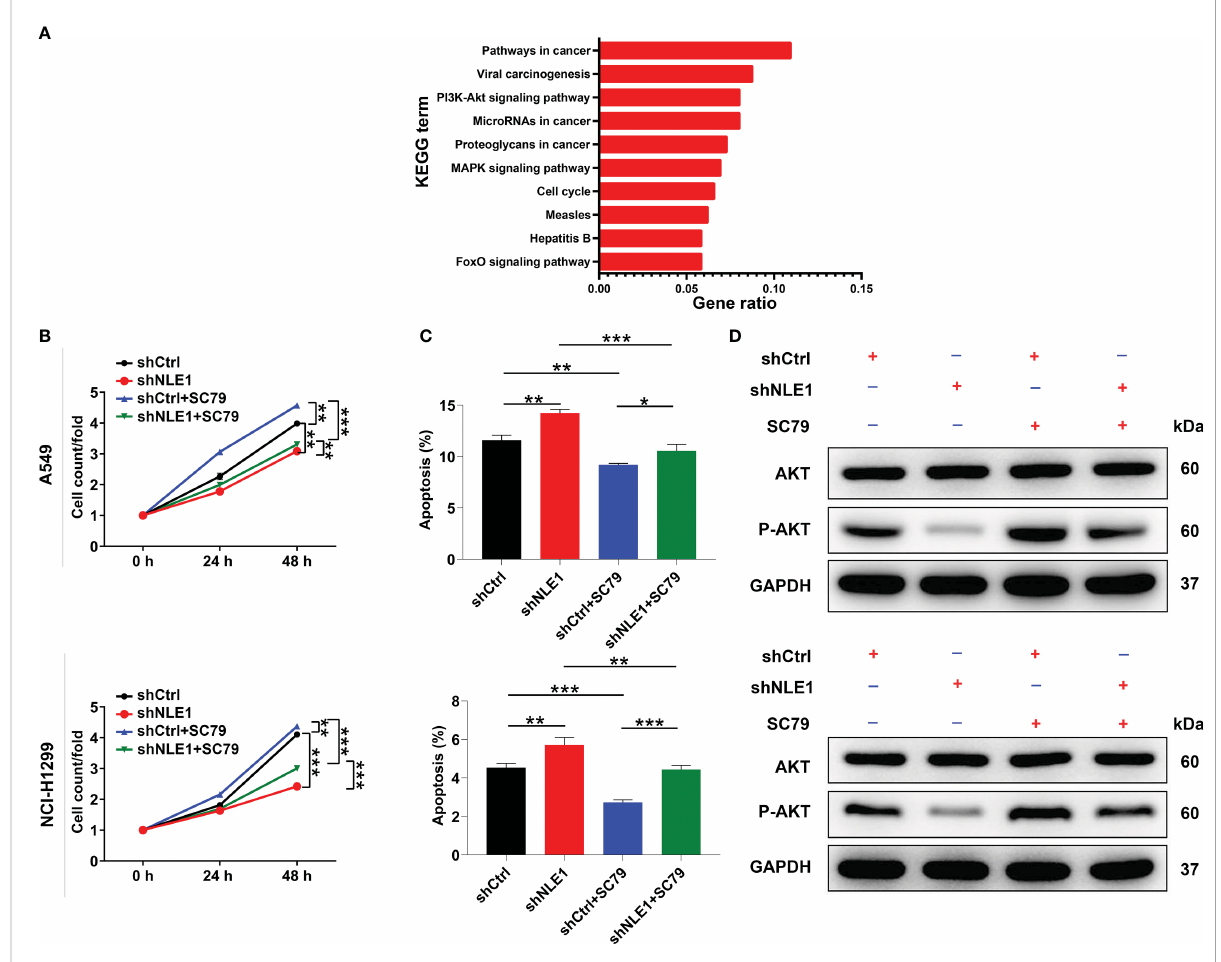
FIGURE 4 NLE1 regulated non − small − cell lung cancer via the Akt signaling pathway. (A) KEGG pathway analysis was performed using genes whose expression was increased or decreased by NLE1 silencing in PrimeView human gene expression array. (B, C) The cell proliferation levels (B) and apoptosis levels (C) of shCtrl and shNLE1 infected A549 and NCI-H1299 cells were tested after treating with 10 m M SC79. (D) The expression of AKT and p-AKT in shCtrl and shNLE1 A549 and NCI-H1299 cells was detected by western blot after treating with 10 m M SC79. The data are expressed as mean ± SD (n ≥ 3). ** P < 0.01, *** P < 0.001, *P <